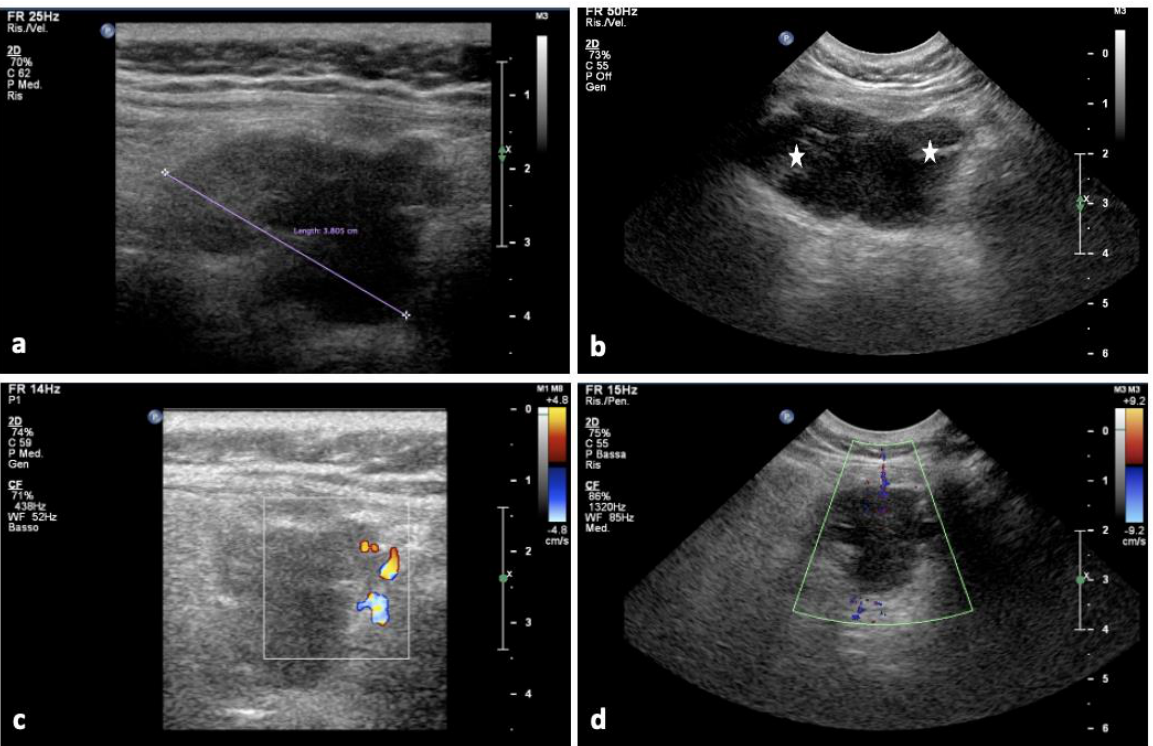
Figure 1. The ultrasound (US) examination demonstrates a hypo-anechoic formation with polylobate margins and a sub-fascial extension to deep left paravertebral muscle site. The lesion has a diameter of 38 mm ( a ) and it is featured by an echogenic heterogeneity due to inner hyper-echoic areas (stars in b ) without vascular signal on color-Doppler and PD ( c – d ).